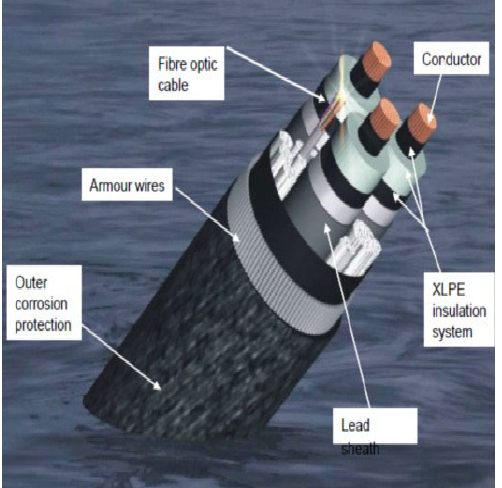
Figure 2. Electric transport cable for offshore farms